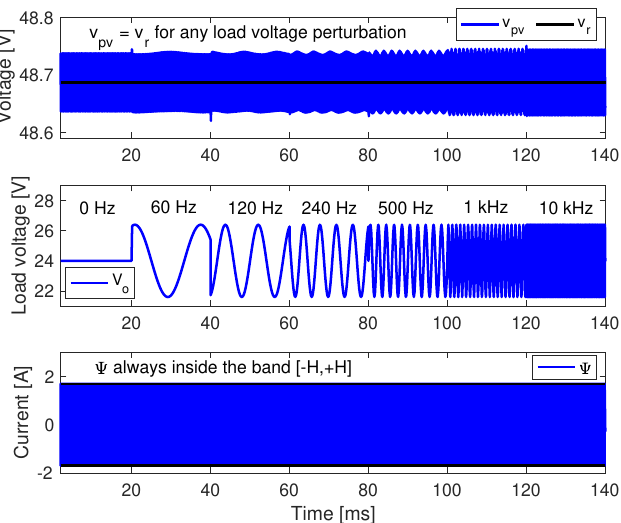
Figure 16. Performance of the PV system to different perturbations in the load